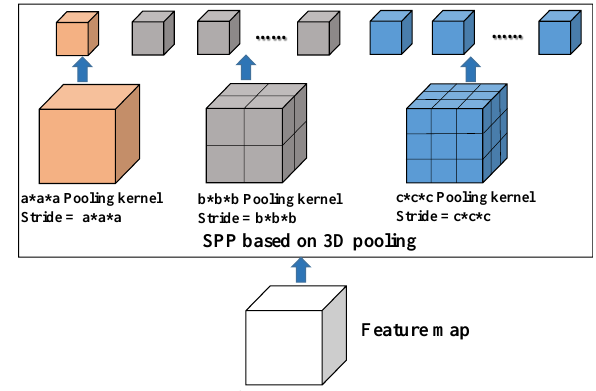
Figure 1. An example of three-level pyramid pooling used 3D pooling. The configuration of the figure is for a network whose feature map size of the top convolutional layer is and the output of the spatial pyramid pooling is {3 × 3 × 3, 2 × 2×2, 1 × 1×1}.